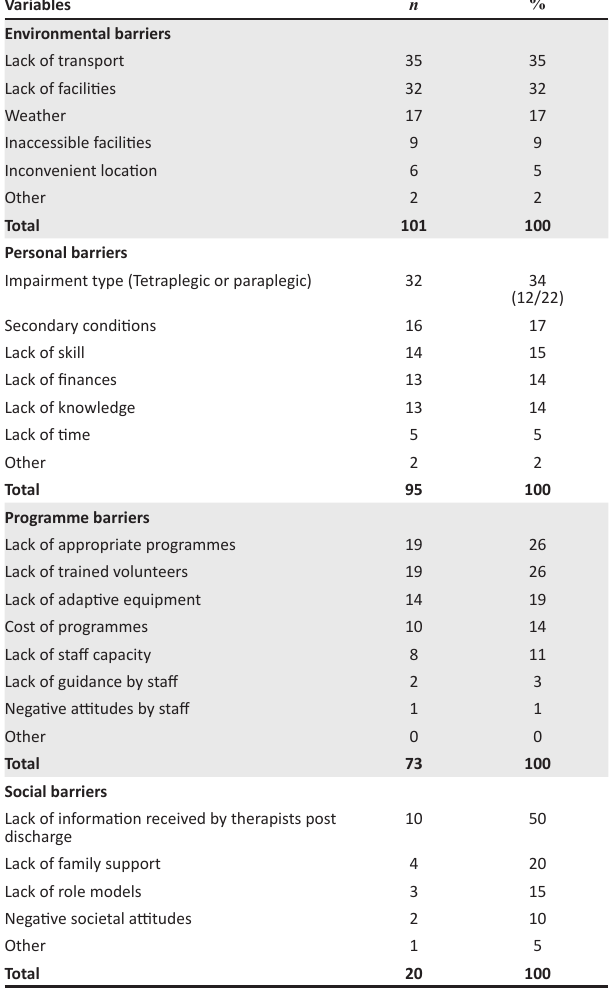
TABLE 1: Number and nature of reported barriers to physical activity.